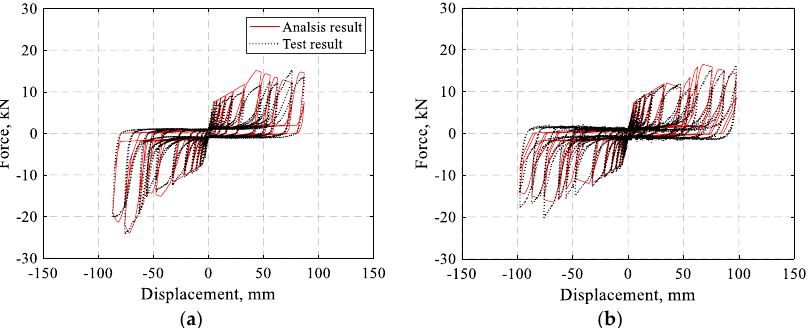
Figure 13. Force–displacement relations of the analytical model and experimental results: ( a ) ST600; ( b ) ST450.